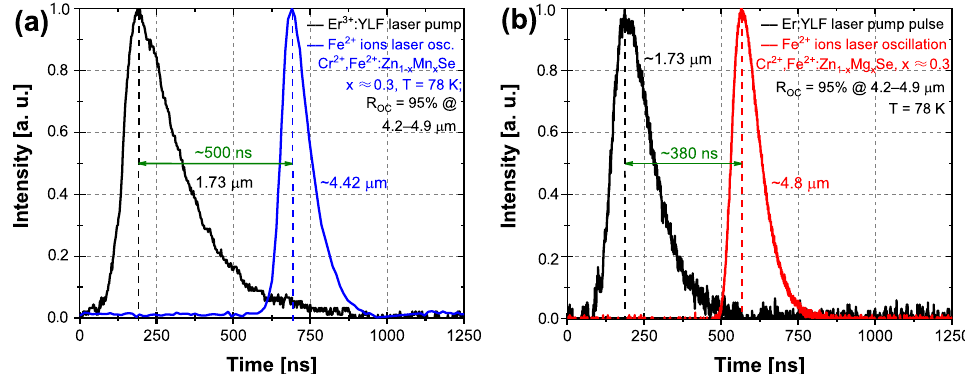
Figure 9. Oscillograms of the Q-switched Er:YLF laser pump pulse at 1.73 µ m (black curves) and Fe 2 + laser oscillation in the case of the Cr 2 + → Fe 2 + ions’ energy transfer for the temperature of 78K. ( a ) Cr,Fe:Zn 1 − x Mn x Se (x ≈ 0.3)—blue curve. ( b ) Cr,Fe:Zn 1 − x Mg x Se (x ≈ 0.3)—red curve.